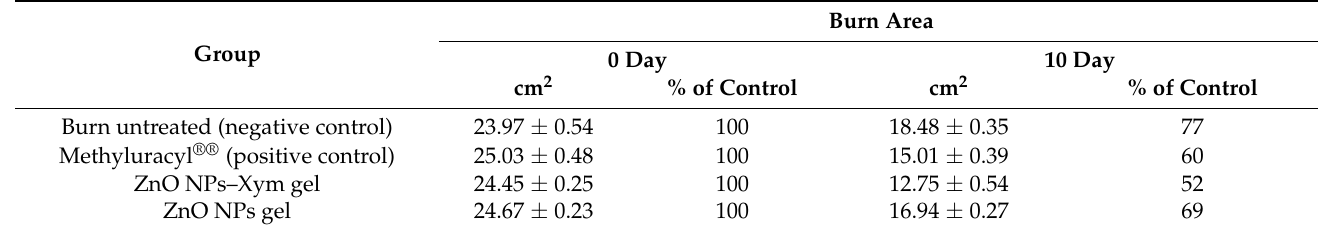
Table 5. Change in wound area during treatment ( n = 3, p <